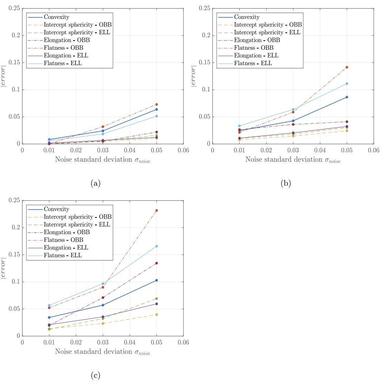
Absolute error of shape parameters for images with increasing levels of blur and noise: (a) σblur = 1; (b) σblur = 3; (c) σblur = 5. Flatness and elongation are calculated as in. The particle dimensions are calculated using an oriented bounding box (OBB) and a fitted ellipsoid (ELL).